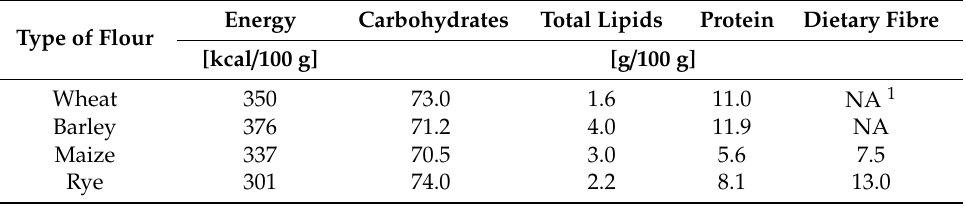
Table 1. Nutritional values of used flours (information obtained from the package of each